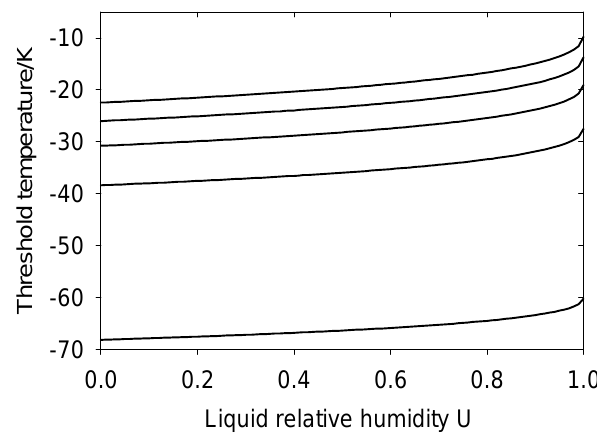
Fig. A2. Differences between fits (Eqs. 10 and A16) and exact solu- tions for (bold curve:) contrail threshold temperature at liquid satu- ration T LM = T LC (U = 1 ) and (thin cuves:) for T LC (U) at various values of liquid relative humidity U .